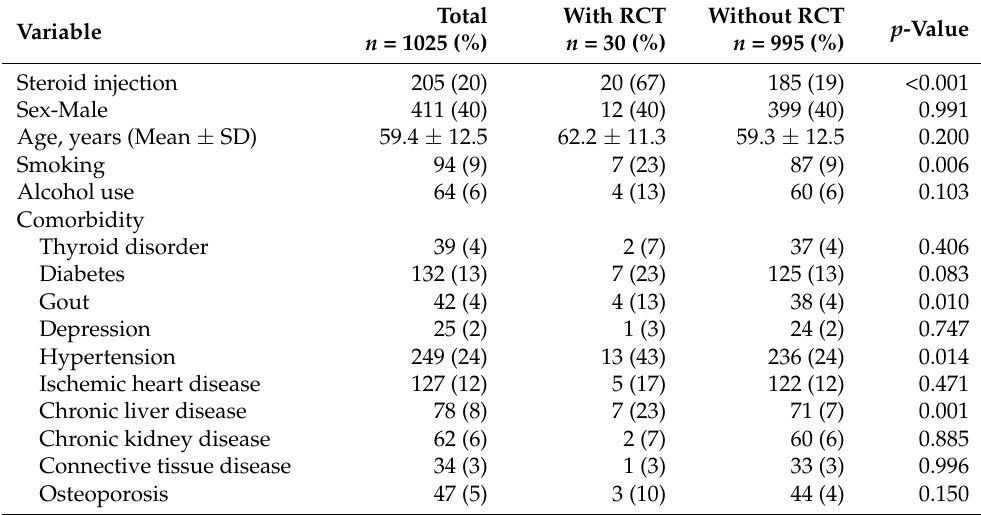
Table 1. Characteristics of the study population at the endpoint.